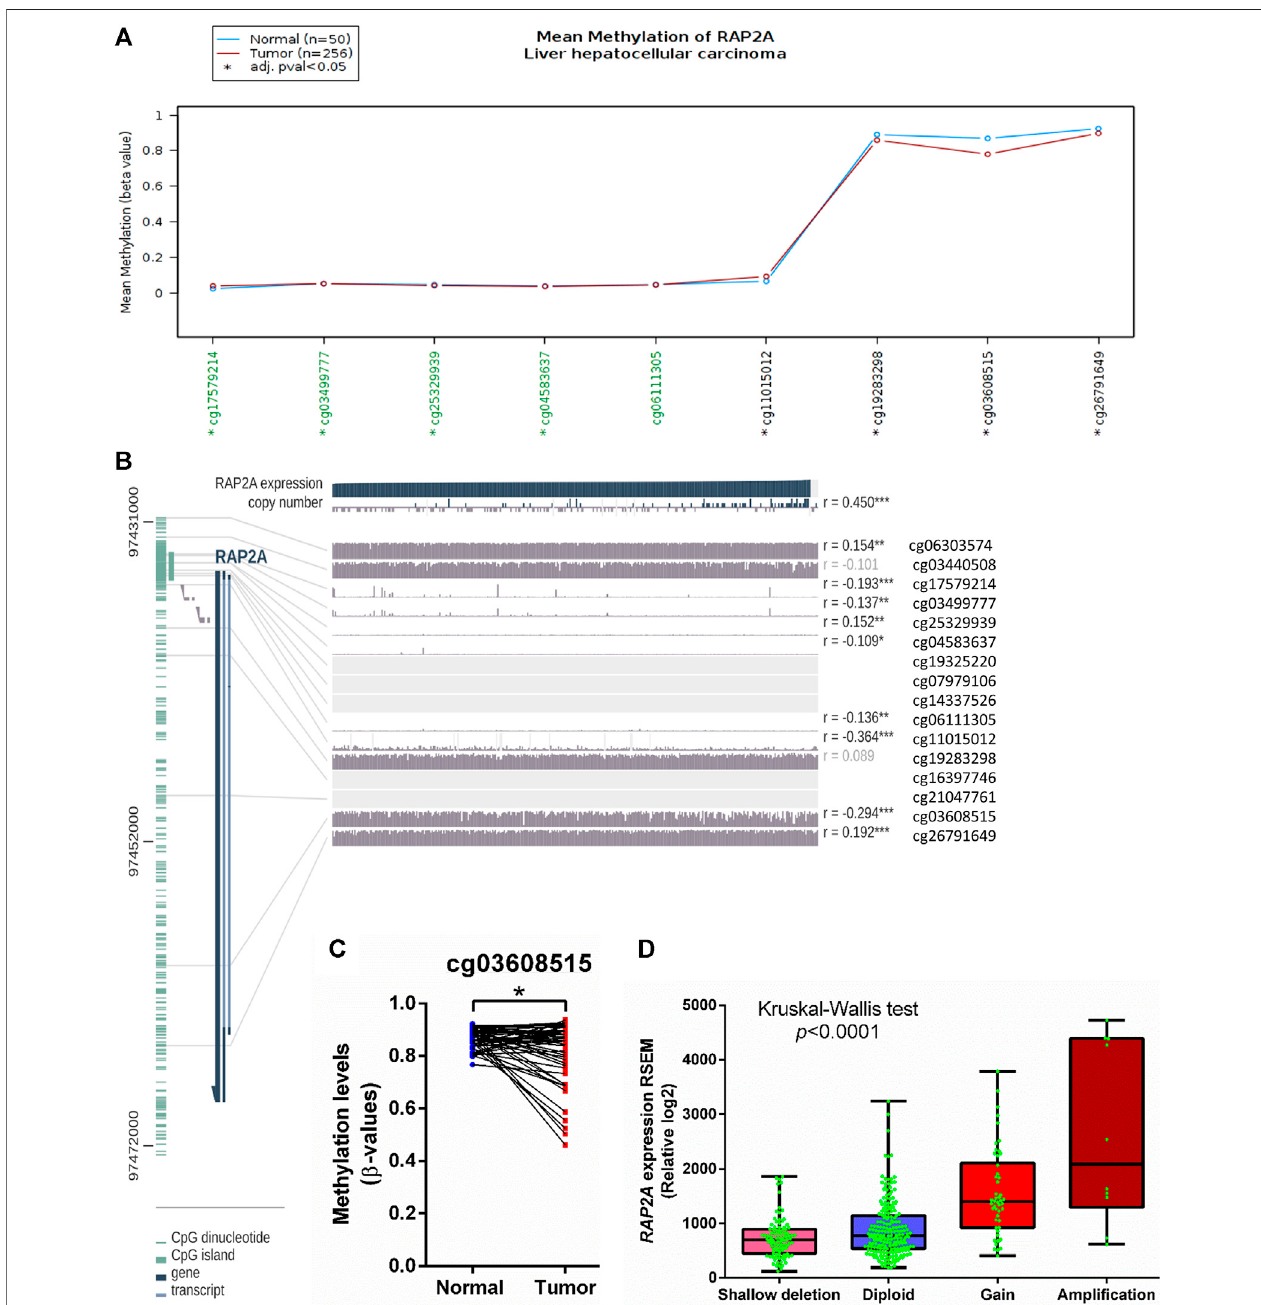
FIGURE 6 | Association of mRNA expression of RAP2A with its copy number variation and DNA methylation in TCGA-LIHC dataset. (A) Comparison of DNA methylation level of RAP2A between tumor tissues and normal tissues. (B) Correlation of RAP2A mRNA expression of RAP2A with its copy number variation and DNA methylation in tumor tissues. (C) Comparison of DNA methylation level of RAP2A at an intragenic site associated probe cg03608515. (D) Comparison of RAP2A gene expression among different copy number based groups in TCGA-LIHC dataset. *** p < 0.001; ** p < 0.01; * p < 0.05. Insigni fi cant associations ( p > 0.05), are faded.